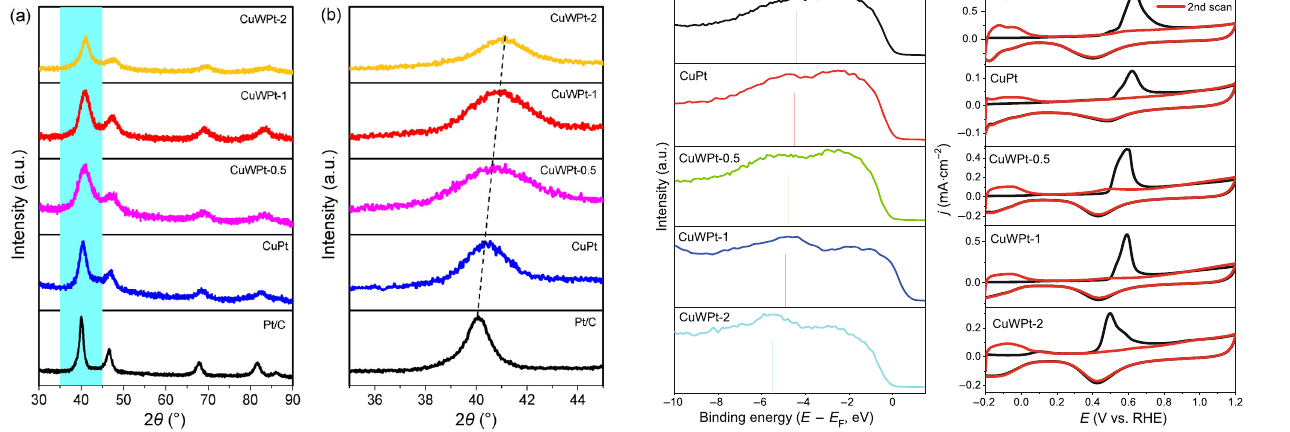
Figure 3 (a) The Pt XPS valence band spectra of ternary CuWPt-2, CuWPt-1, CuWPt-0.5, binary CuPt alloy and commercial Pt/C catalyst; (b) the corresponding CO stripping curves on these catalysts at a scan rate of 50 mV · s − 1 in 0.1 M HClO 4